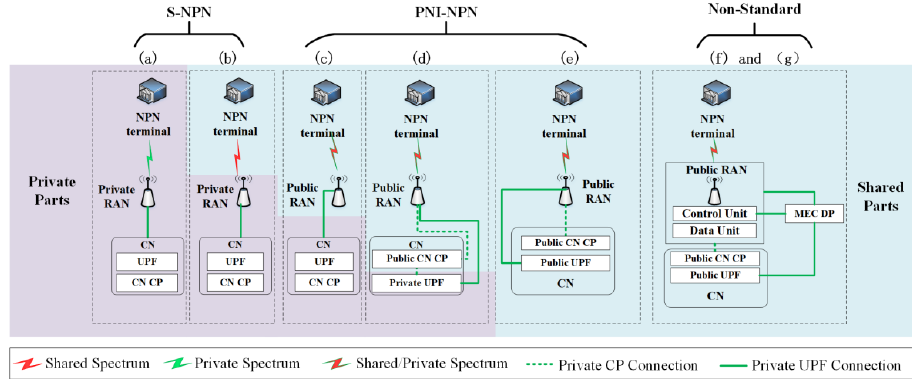
Figure 2. Deployments of NPNs. ( a ) Isolated NPN ( b ) Shared spectrum-only NPN ( c ) Shared RAN NPN ( d ) Shared RAN and CP NPN ( e ) Shared RAN and CN NPN ( f ) N3 LBO NPN ( g ) F1 LBO NPN.